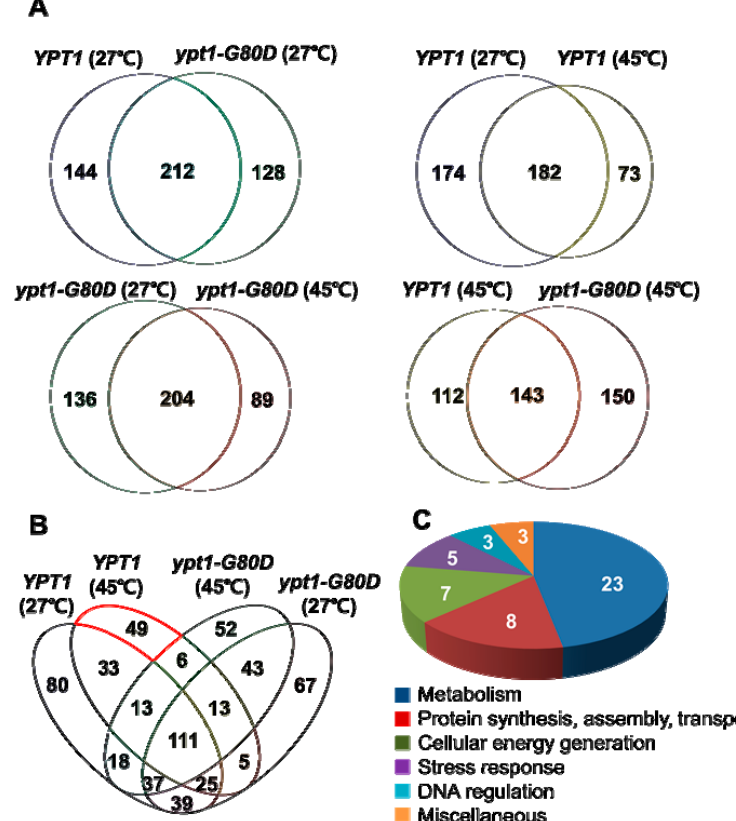
Figure 6. Analyses of LC/MS Data. ( A ) Venn diagrams showing the numbers of proteins identified by the LC/MS analysis in extracts of YPT1 and ypt1-G80D cells incubated at 27 °C (upper left), extracts of YPT1 cells incubated at 27 °C or 45 °C (upper right), extracts of ypt1-G80D cells incubated at 27 °C or 45 °C (lower left), and extracts of YPT1 and ypt1-G80D cells incubated at 45 °C (lower right). ( B ) Venn diagram showing the relationships between the proteins identified by the LC/MS analysis in extracts of YPT1 and ypt1-G80D cells incubated at 27 °C or 45 °C. The group of 49 proteins that was induced at 45 °C in YPT1 cells but not ypt1-G80D cells is indicated by the red outline. ( C ) Pie chart showing distribution of these 49 proteins among different cellular processes.